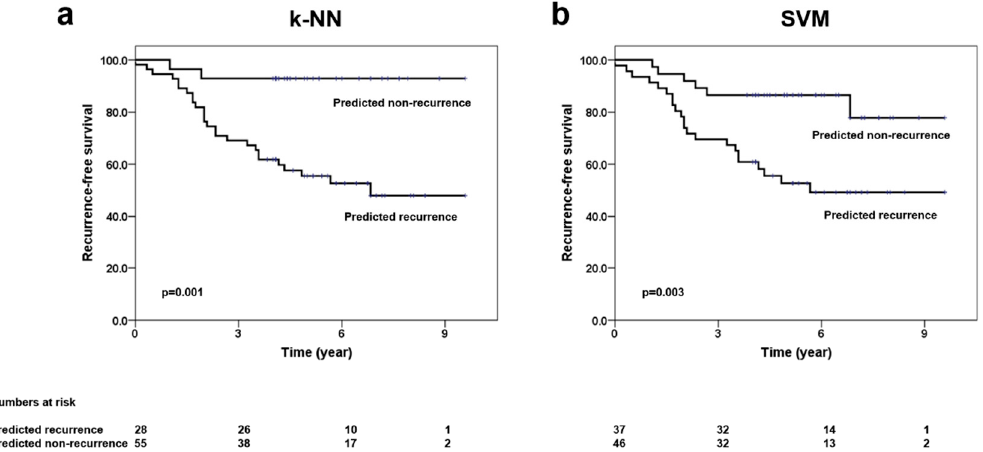
Figure 4. Kaplan–Meier survival plots showing recurrence-free survival based on predicted groups (recurrence vs. no recurrence). Legends: Survival curves showing the differences in the recurrence- free survival outcomes as obtained from the predicted groups using the k-NN model ( a ) and SVM model ( b ) at week 4 time-point, including all features (QUS + QUS-Tex 1 + QUS-Tex 1 -Tex 2 ).